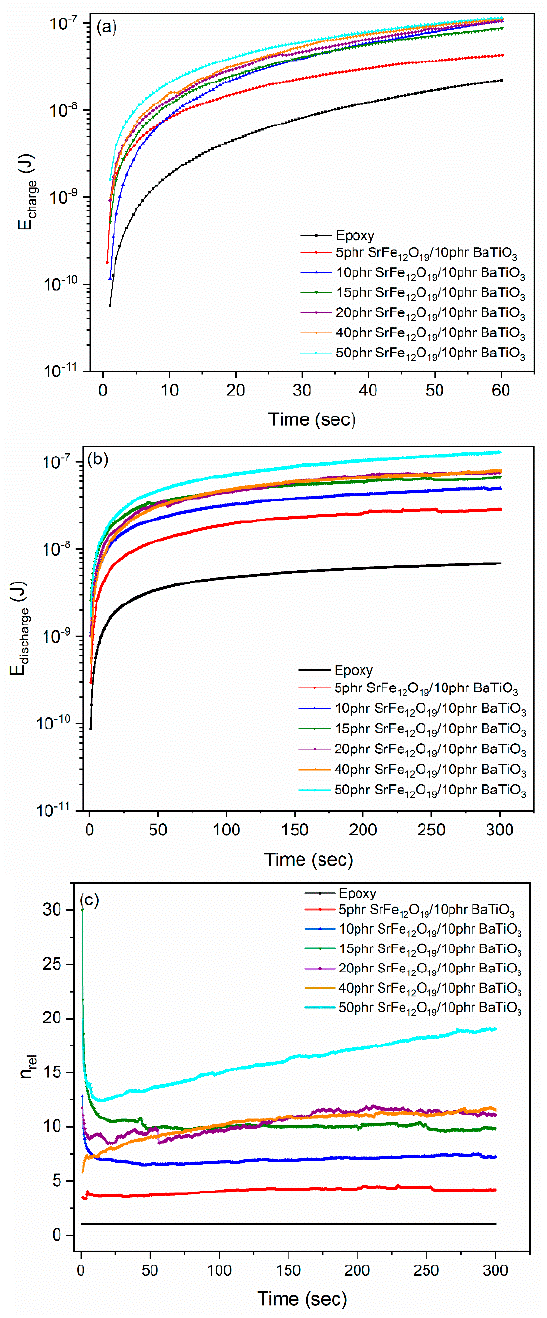
Figure 15. ( a ) Charging (storing) energy, ( b ) discharging (retrieving) energy, and ( c ) the relative retrieved energy, as a function of time at room